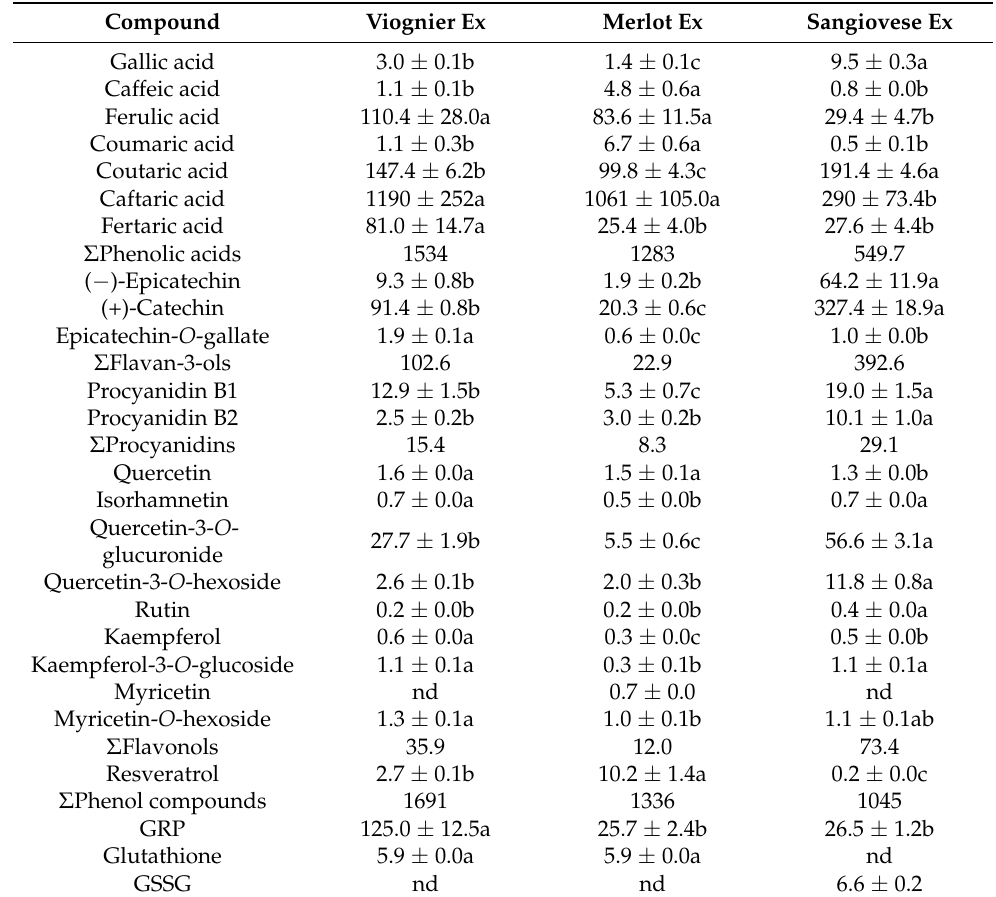
Table 1. Composition of the UG